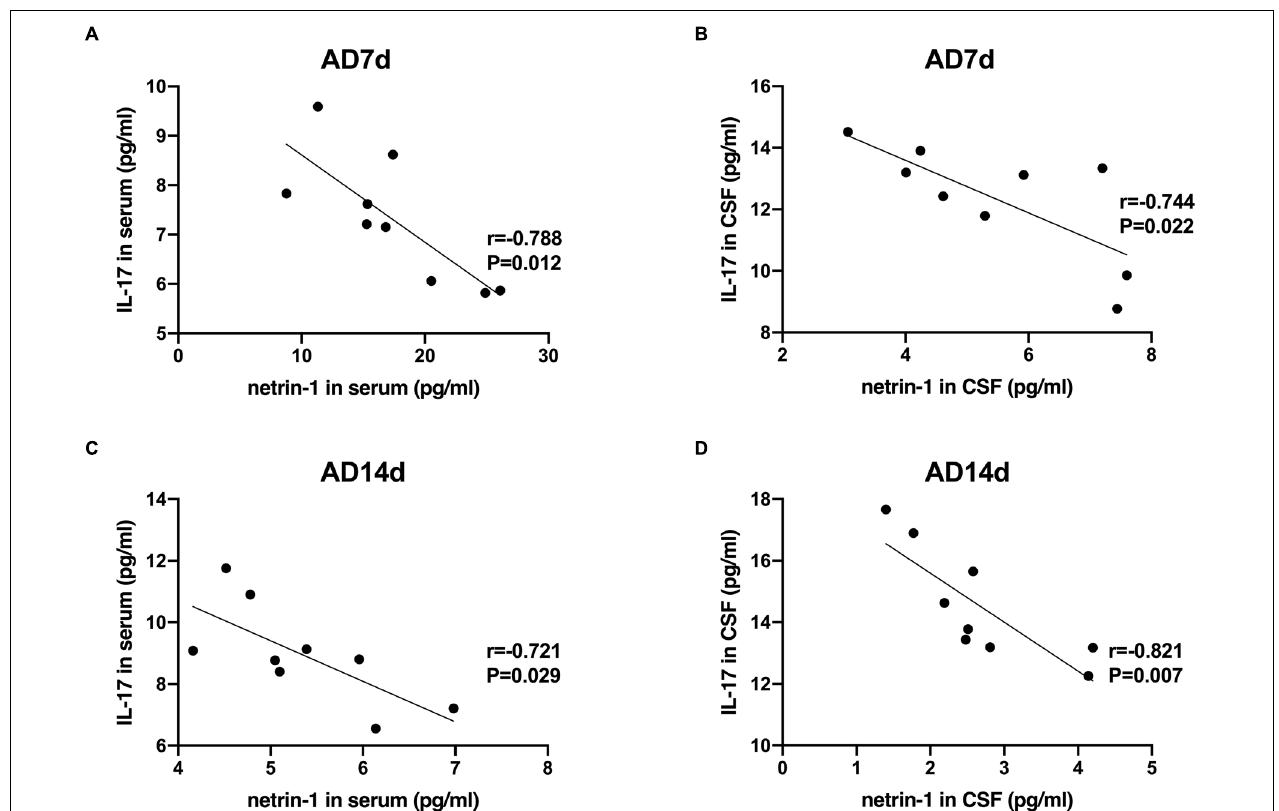
FIGURE 8 | Negative correlations between netrin-1 and IL-17 concentrations in the serum and CSF of AD rats. Negative correlations were obtained between serum netrin-1 and IL-17 concentrations in the AD7d (A) and AD14d (C) groups. Negative correlations were obtained between CSF netrin-1 and IL-17 concentrations in the AD7d (B) and AD14d (D)